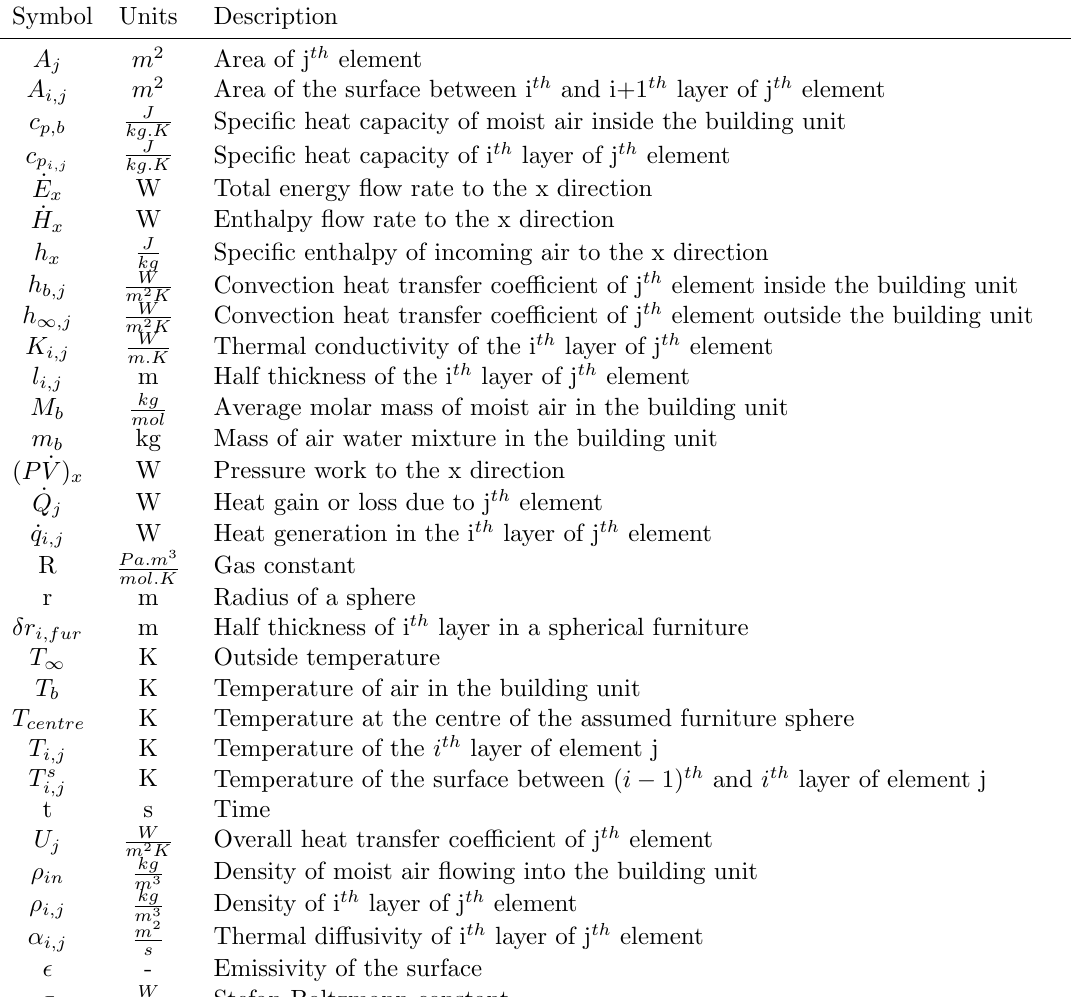
Table 6: Nomenclature for the